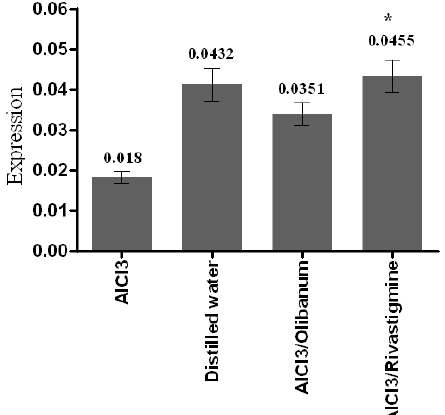
Fig. 5. Effect of the therapeutic protocol treatments of Rivastigmine and Frankincense on the FMR1 gene expression: AlCl /Olibanum; rats received AlCl 3 weeks which were then followed by Frankincense administration